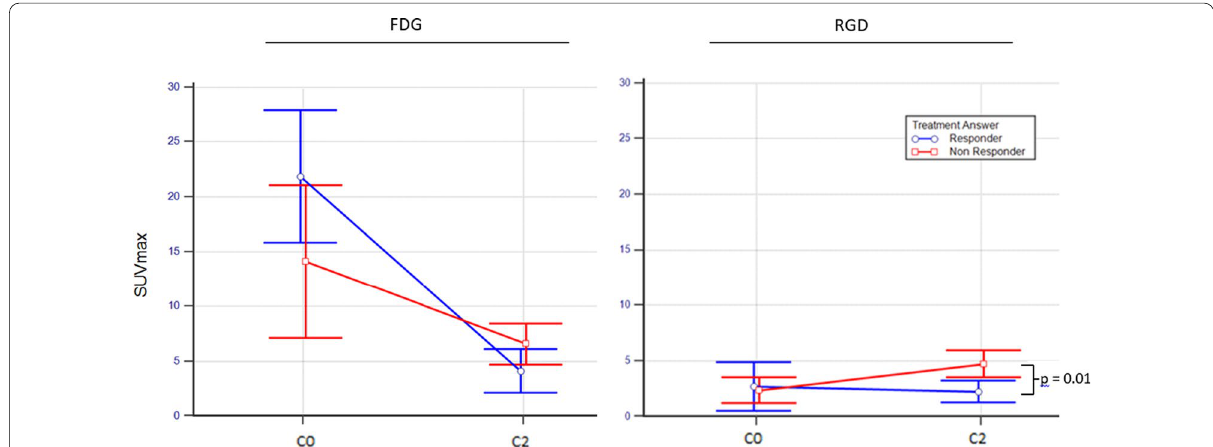
Fig. 5 FDG (left) and RGD (right) SUVmax on initial (C0) and interim (C2) PET-CT according to final Deauville score (DS) (non-responder responder 1, 2 or =